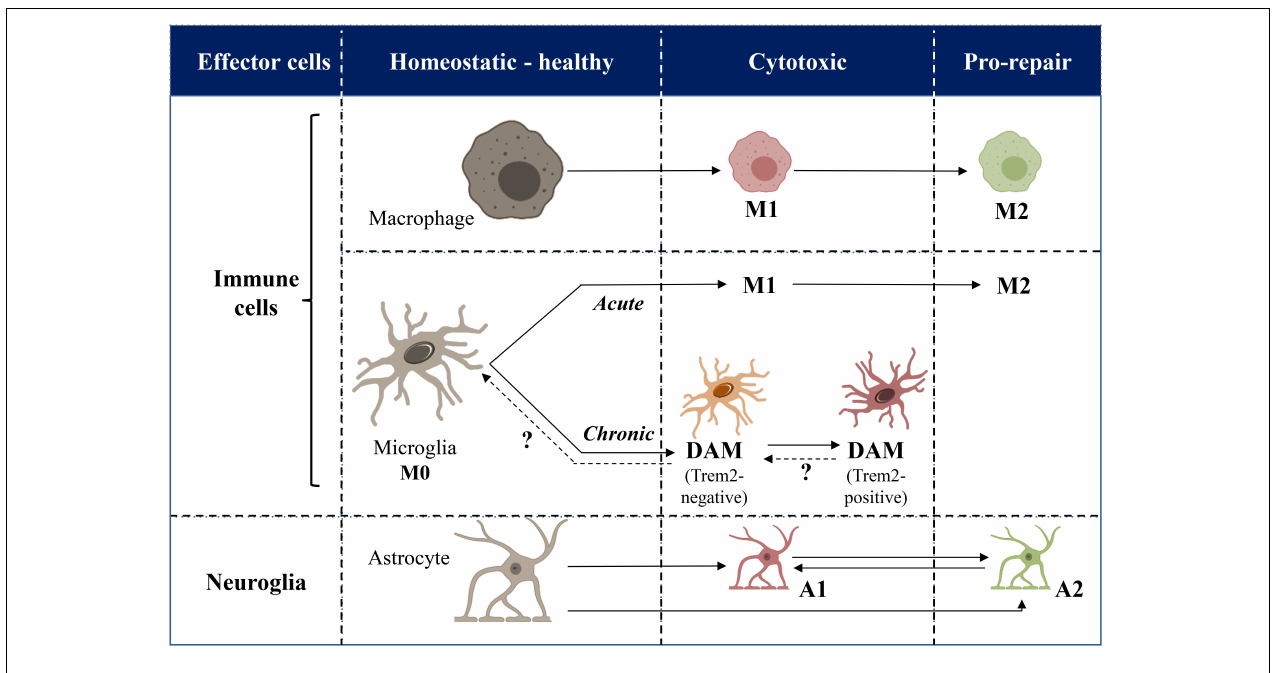
FIGURE 1 | Cellular mechanisms of inflammation and neuroinflammation: a schematic picture. Immune and neural effector cells of inflammation and neuroinflammation are represented in horizontal rows. Healthy and pathological phenotypes are categorized in columns. Plain vs. dashed arrows indicate demonstrated vs. hypothetical switches from one phenotype to another. Acute vs. chronic diseases are indicated in italic. DAM, disease-associated